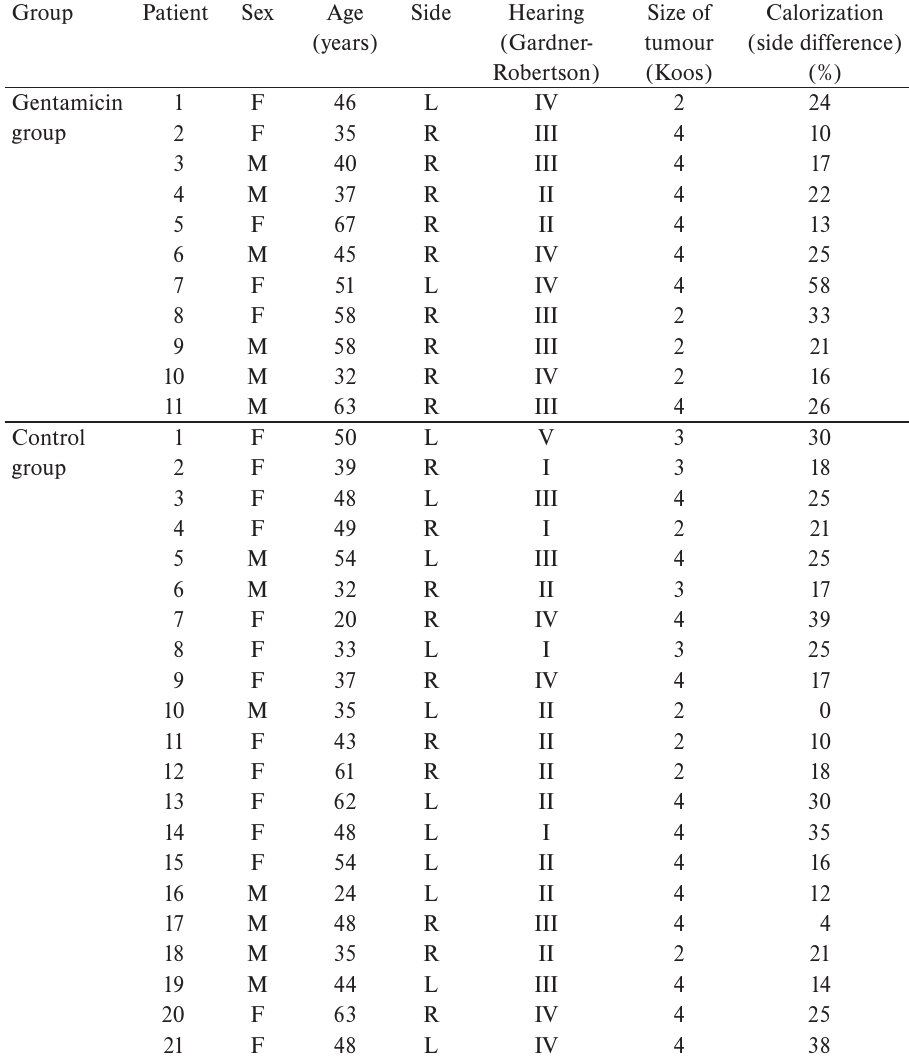
Table 1. Patient